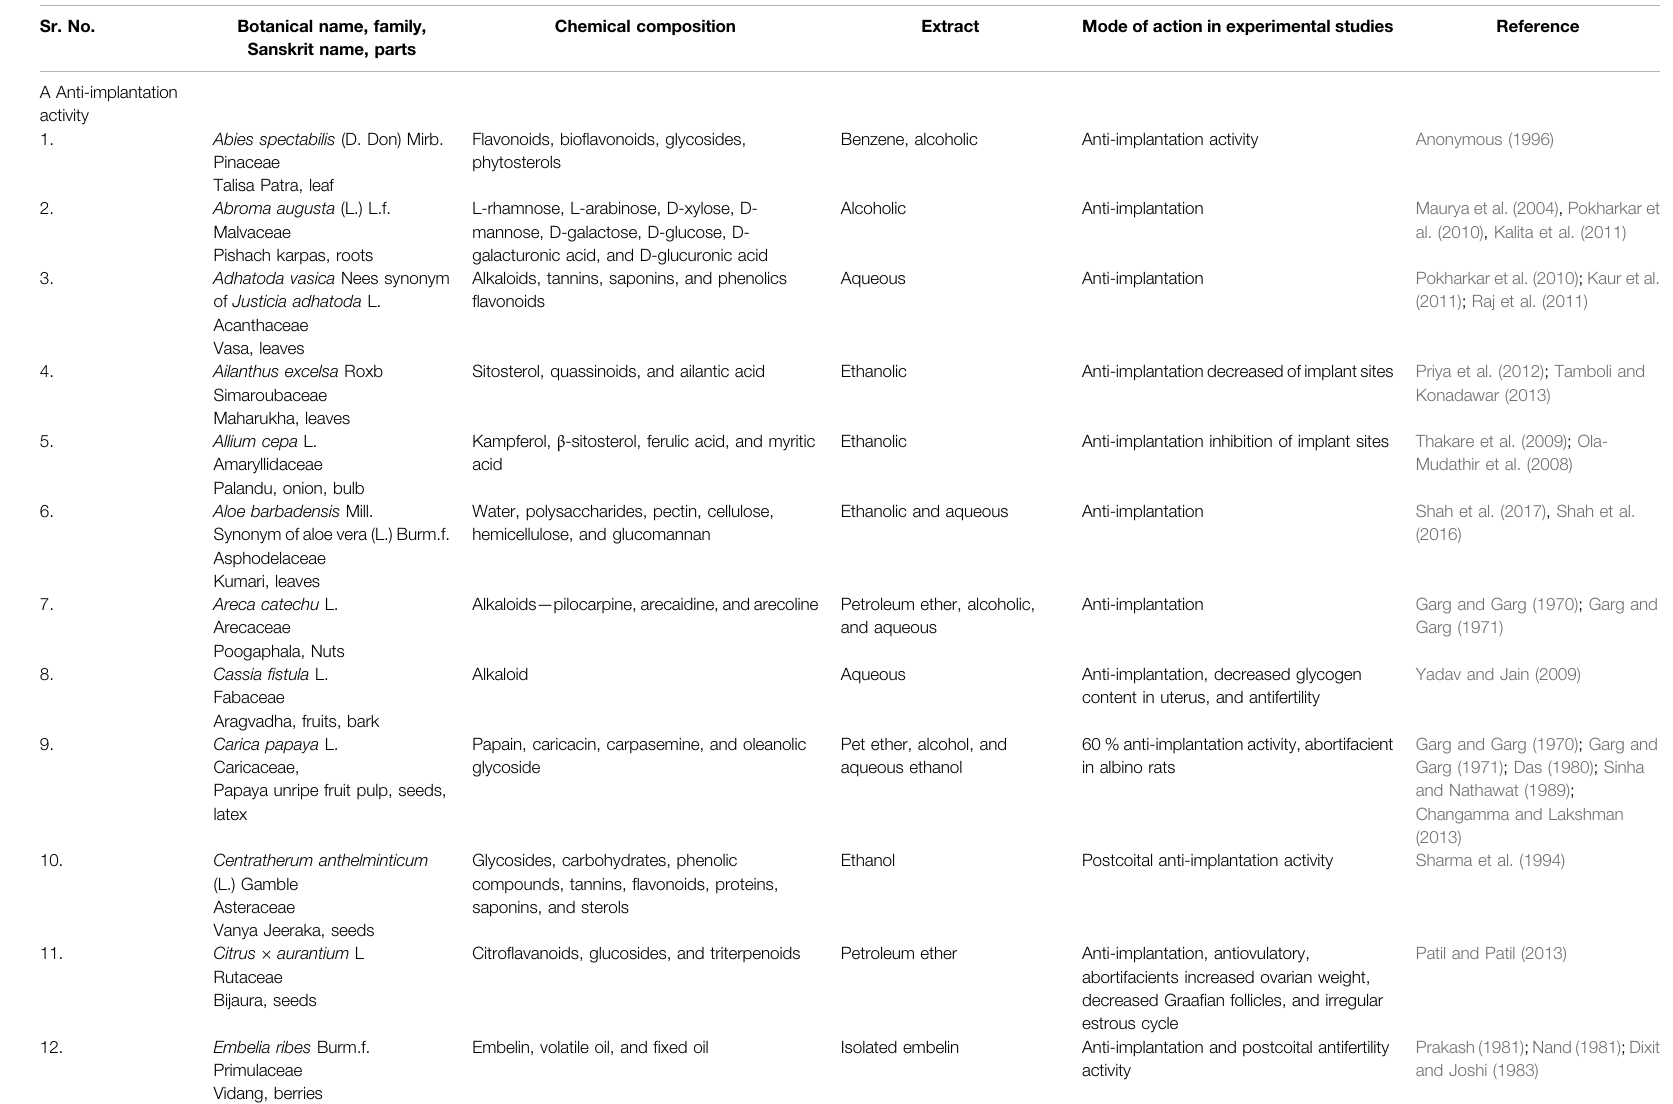
TABLE 2 | Medicinal plants and their phyotoconstituents validated for various female/male contraceptive activities. Different contraceptive activities studied on medicinal plants could be categorized as follows. Female contraceptive activities: (2A) anti-implantation activity, (2B) aborti fi cation, (2C) antifertility, (2D) antiovulatory, and (2E) antiestrogenic activity. Male contraceptive activities: (2F) antispermatogenic, (2G) spermicidal, and (2H) antiandrogenic